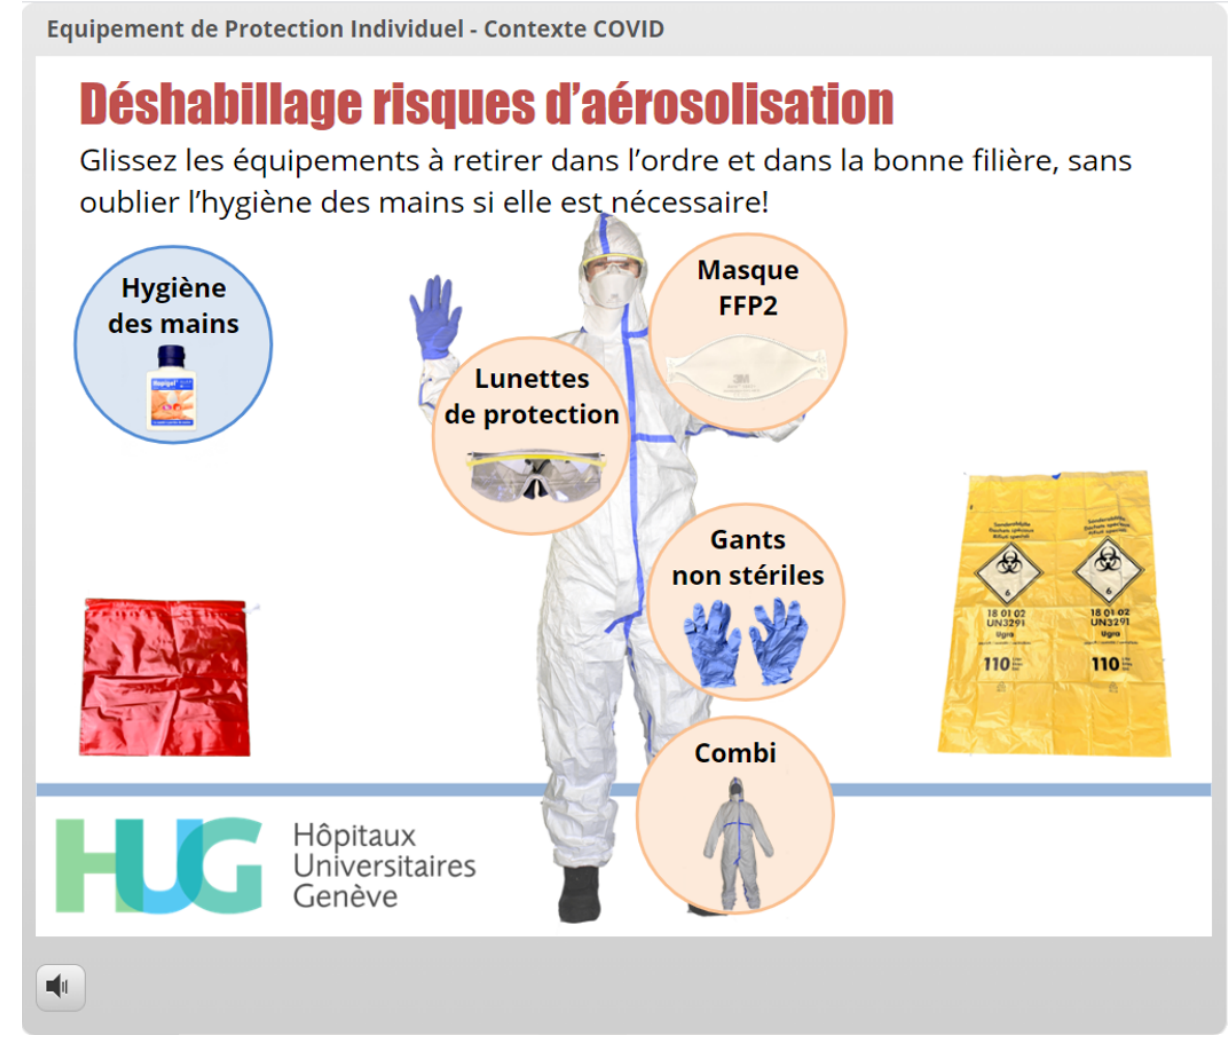
Figure 15. Gamification of the PPE doffing sequence. PPE worn by the prehospital provider must be dragged either to a biohazard trash bag (bottom right) or to a bag designed to hold reusable materials, such as protective goggles (bottom